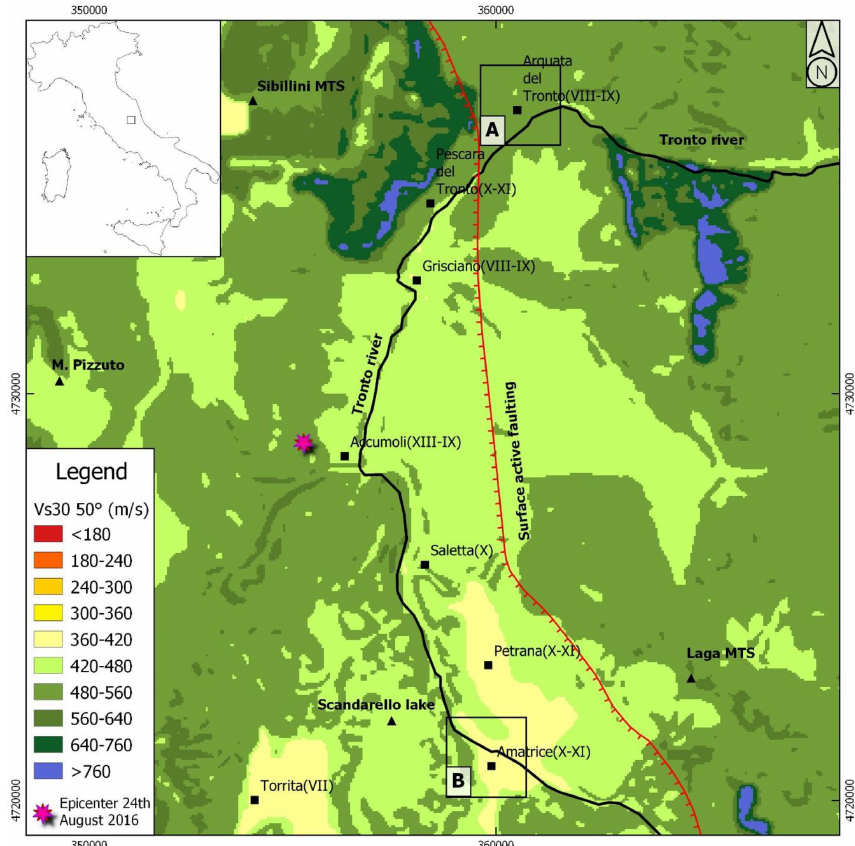
Figure 7. V S30 maps for the area of interest shown in Fig. 6. It should be noted that two extended areas in the southern part of the map (i.e., near the villages of Petrana and Torrita) are characterized by the lowest values of V S30 inducing the highest Sa 0 . 3 values (i.e., valley effect) as shown in Fig. 6.